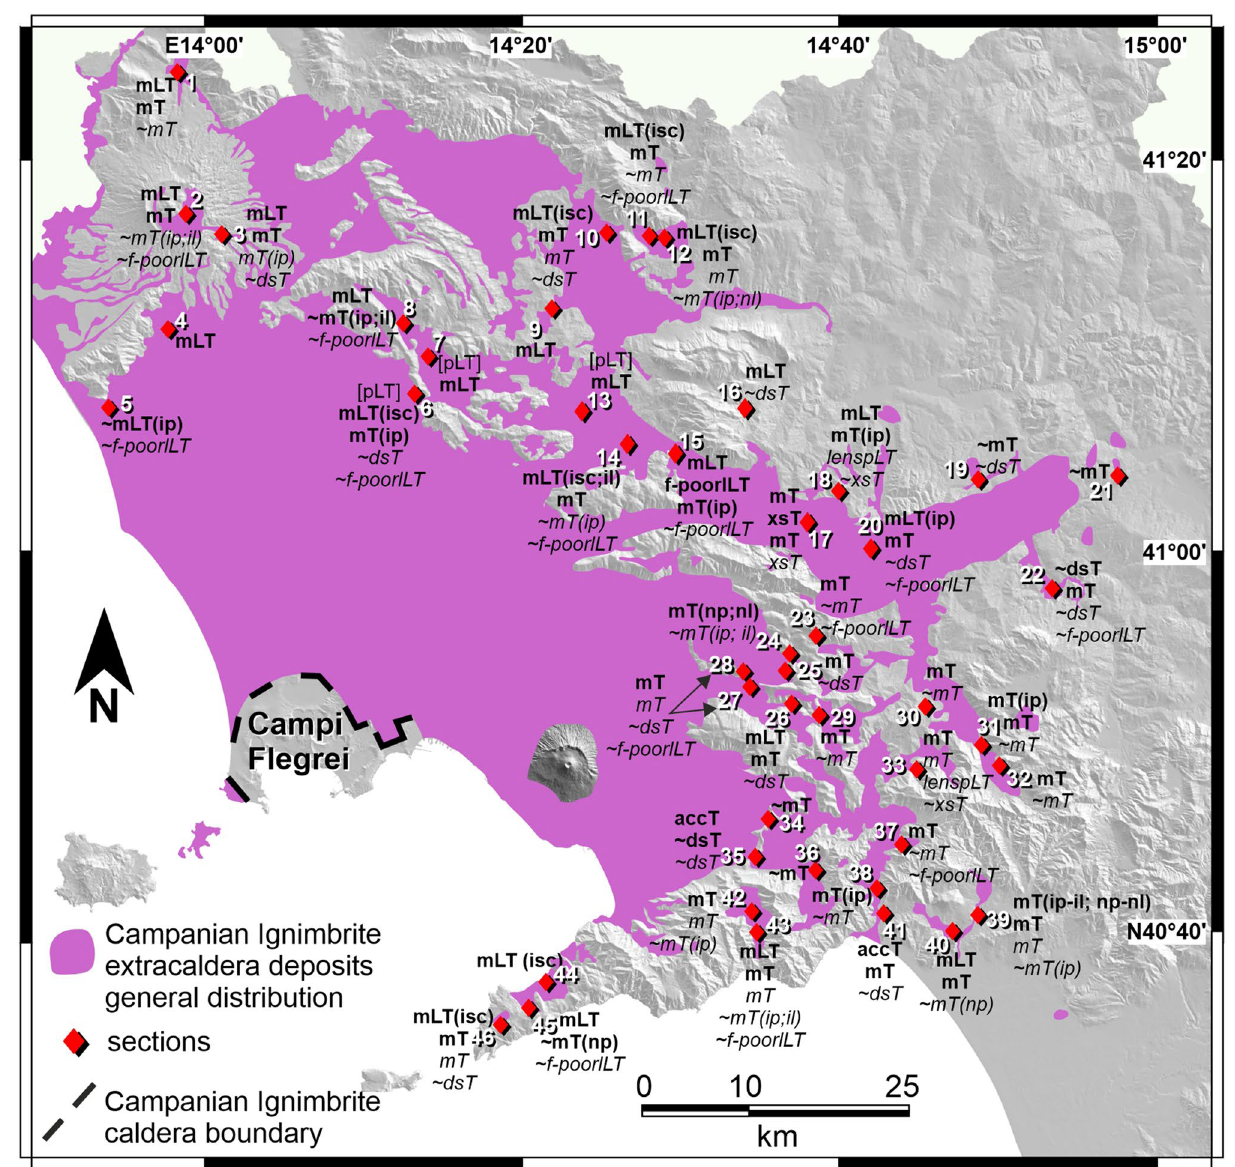
Figure 5. Distribution of lithofacies recognized in the medial pyroclastic current deposit of the Campanian Ignimbrite eruption throughout the investigated area and in each studied section. Section numbers and location as in Fig. 1. Two or more superimposed lithofacies at same location represent a vertical facies variation. Italic refers to facies recognized in the unconsolidated stratified ash flow deposit, bold refers to WGI while facies recognized in coarse pumice flow deposit are reported in square brackets (sec. 6, 7 and 13). Lithified yellow tuff facies are not reported because are the same of the underlying WGI. Facies abbreviation: f-poorlLT (fines-poor lithic lapilli tuff); mT or mLT (massive tuff or massive lapilli tuff), isc/ip (inverse graded scoria/pumice), np (normal graded pumice), il/nl (inverse/normal graded lithic); dsT (diffuse stratified tuff); xsT (cross stratified tuff), pLT (pumice lapilli tuff); lenspLT (lenses of pumice lapilli tuff); accT (accretionary lapilli-bearing). Figure is generated using CorelDRAW Graphics Suite 2020 for Windows v. 22.0.0.412 (https ://www.corel draw.com/it/ produ ct/corel